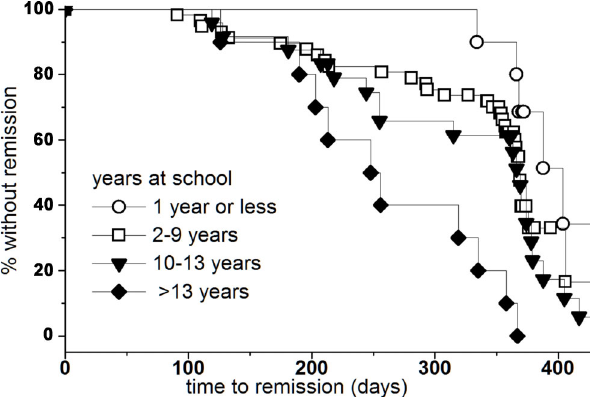
Figure 2 - Kaplan-Meier plot analyzing the median time to complete cytogenetic remission according to the patients ’ educational levels: 0–1 year spent in school (median 404 days), 2–9 years (basic level), 10–12 years (secondary level) (median 369 days) and X 13 years (university level) (median 252 days). Log- rank test p = 0.006.